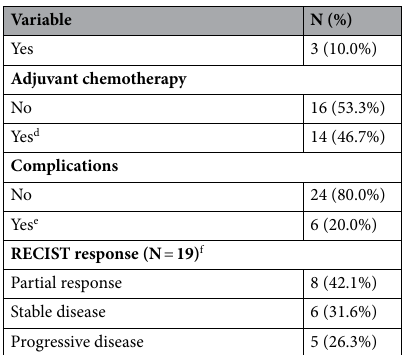
Table 1. Patient, tumor, and treatment-related variables. a Other histologies included colon (1), gastric (1), mesothelioma (2), leiomyosarcoma (1), and liposarcoma (1). b Previous abdominal surgeries included appendectomy (9), hysterectomy (2), total abdominal hysterectomy with bilateral salpingo-oophorectomy (7), cholecystectomy (2), splenectomy (1), partial colectomy (1), Roux-en-Y gastric bypass (1), inguinal hernia repair (1), and prior CRS-HIPEC (3). c Neoadjuvant chemotherapy regimens (N = 17) included carboplatin/ paclitaxel (8), carboplatin/taxotere/bevacizumab (1), FOLFOX (1), FOLFIRI (1), CapeOx (2), FLOT (1), adriamycin/ifosfamide/mesna (1), and cisplatin/pemetrexed/ bevacizumab (2). In addition, one patient with gastric carcinomatosis received nivolumab, and one patient with sarcomatosis received selinexor. Thus, total patients who received some form of neoadjuvant systemic therapy was 19. d Adjuvant chemotherapy regimens included carboplatin/paclitaxel (8), cisplatin/gemcitabine (1) FOLFOX (1), capecitabine/bevacizumab (1), cisplatin/pemetrexed (2), and ramucirumab/paclitaxel (1). e Complications included wound infection (4), incisional hernia (1), and fascial dehiscence (1). None of these complications required re-operation. f Response Evaluation Criteria in Solid Tumors (RECIST) was calculated for 19 patients who received neoadjuvant chemotherapy or other form of neoadjuvant systemic